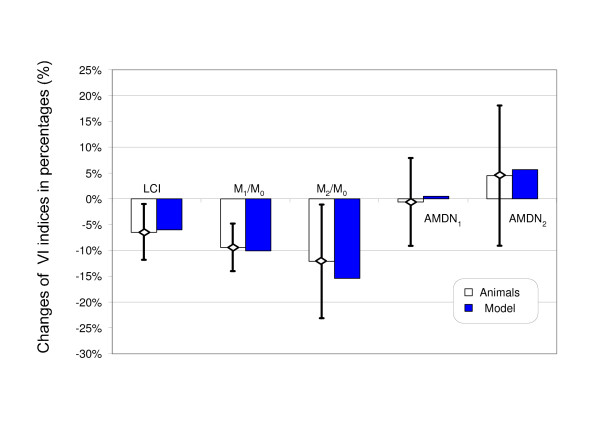
Comparison on the changed VI indices due to increased PIP in the piglets (mean with 95% CI) with the numerically calculated VI indices of a uniformly mixed volume (blue bars) using the same ratios VD/VT and VT/FRC as shown in table 1.